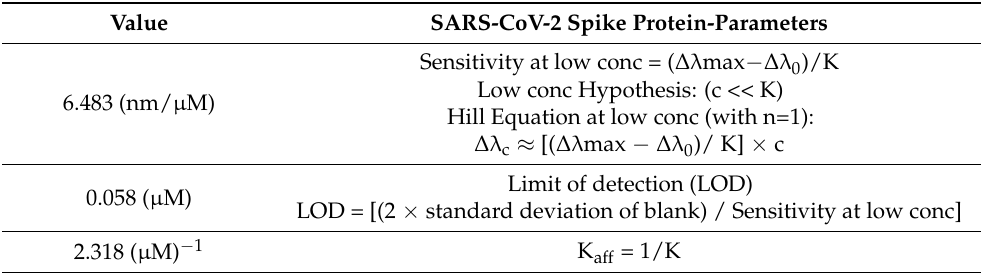
Table 4. Chemical parameters for SARS-CoV-2 Spike protein